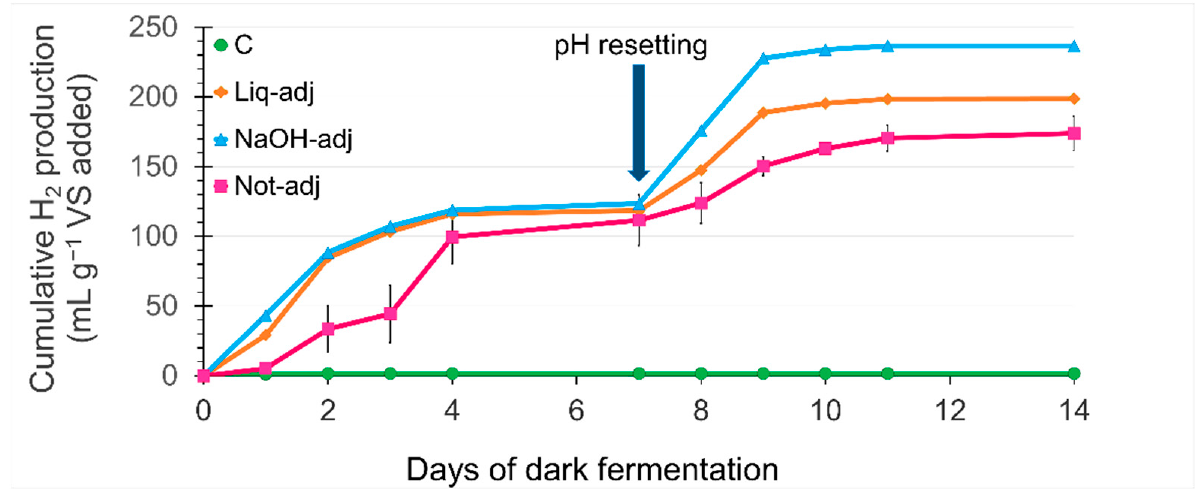
Figure 2. Measurements of the cumulative H 2 production per gram of volatile solids during dark fermentation of differently prepared giant reed hydrolysates: Not-adj (not adjusted initial pH 5.3, pink squares); NaOH-adj (NaOH-adjusted initial pH 8.7, blue triangles); Liq-adj (black liquor-adjusted initial pH 8.7, orange diamonds); C (not treated and not hydrolyzed giant reed control, NaOH-adjusted initial pH 8.7, green circles). The downward vertical arrow indicates the time of pH resetting of all reactors to their initial value with NaOH or black liquor depending on the treatment. Vertical bars represent the standard deviation (n = 3).